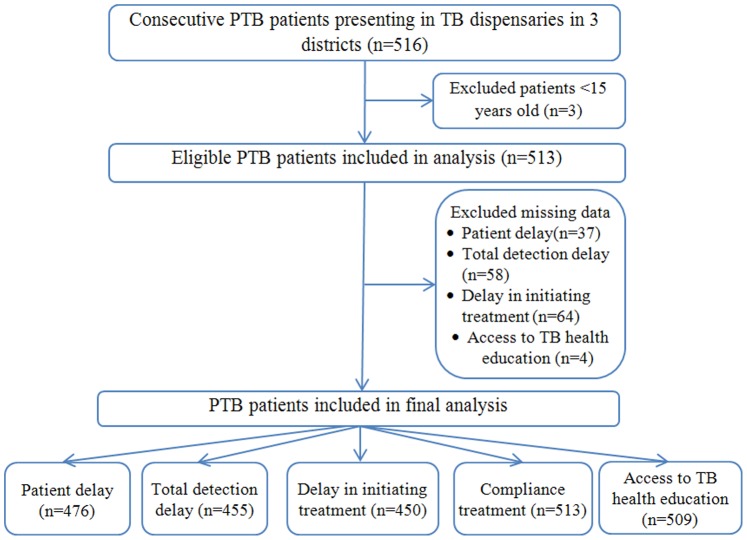
Flow diagram of participant inclusion in the study in Chongqing, China.This flow diagram showed the participants included in the study and final analysis of each related outcome.